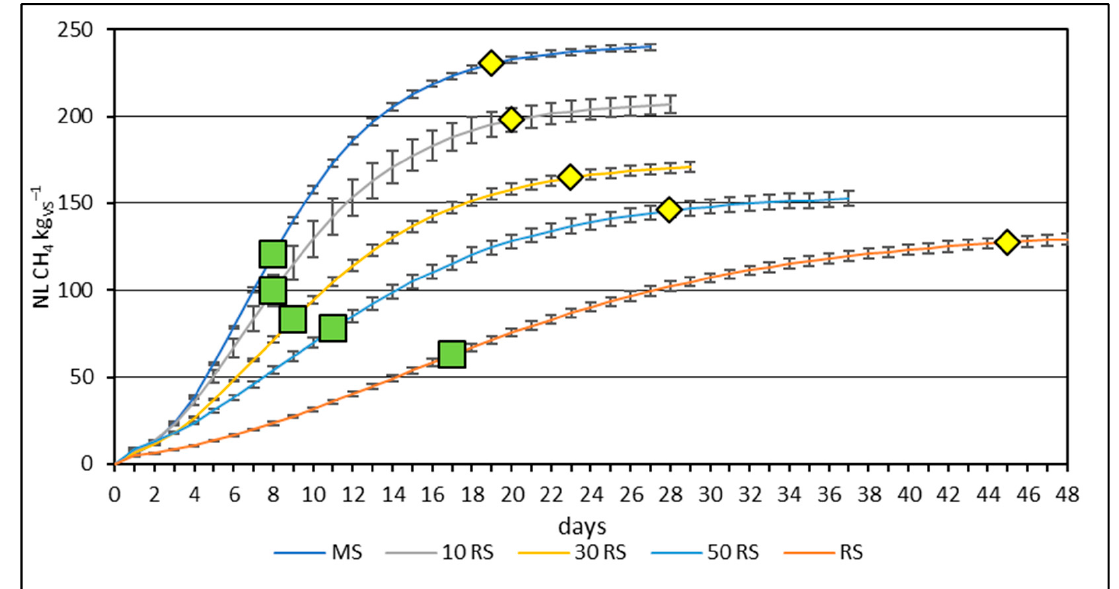
Figure 3. Cumulative methane production from mono- and co-digestion of maize and reed silages. MS—maize silage, 10 RS—maize silage with 10% content of reed silage, 30 RS—maize silage with 30% content of reed silage, 50 RS—maize silage with 50% content of reed silage, and RS—reed silage. The green squares and yellow diamonds mean T50 and T95, respectively. Standard errors are shown as vertical bars.